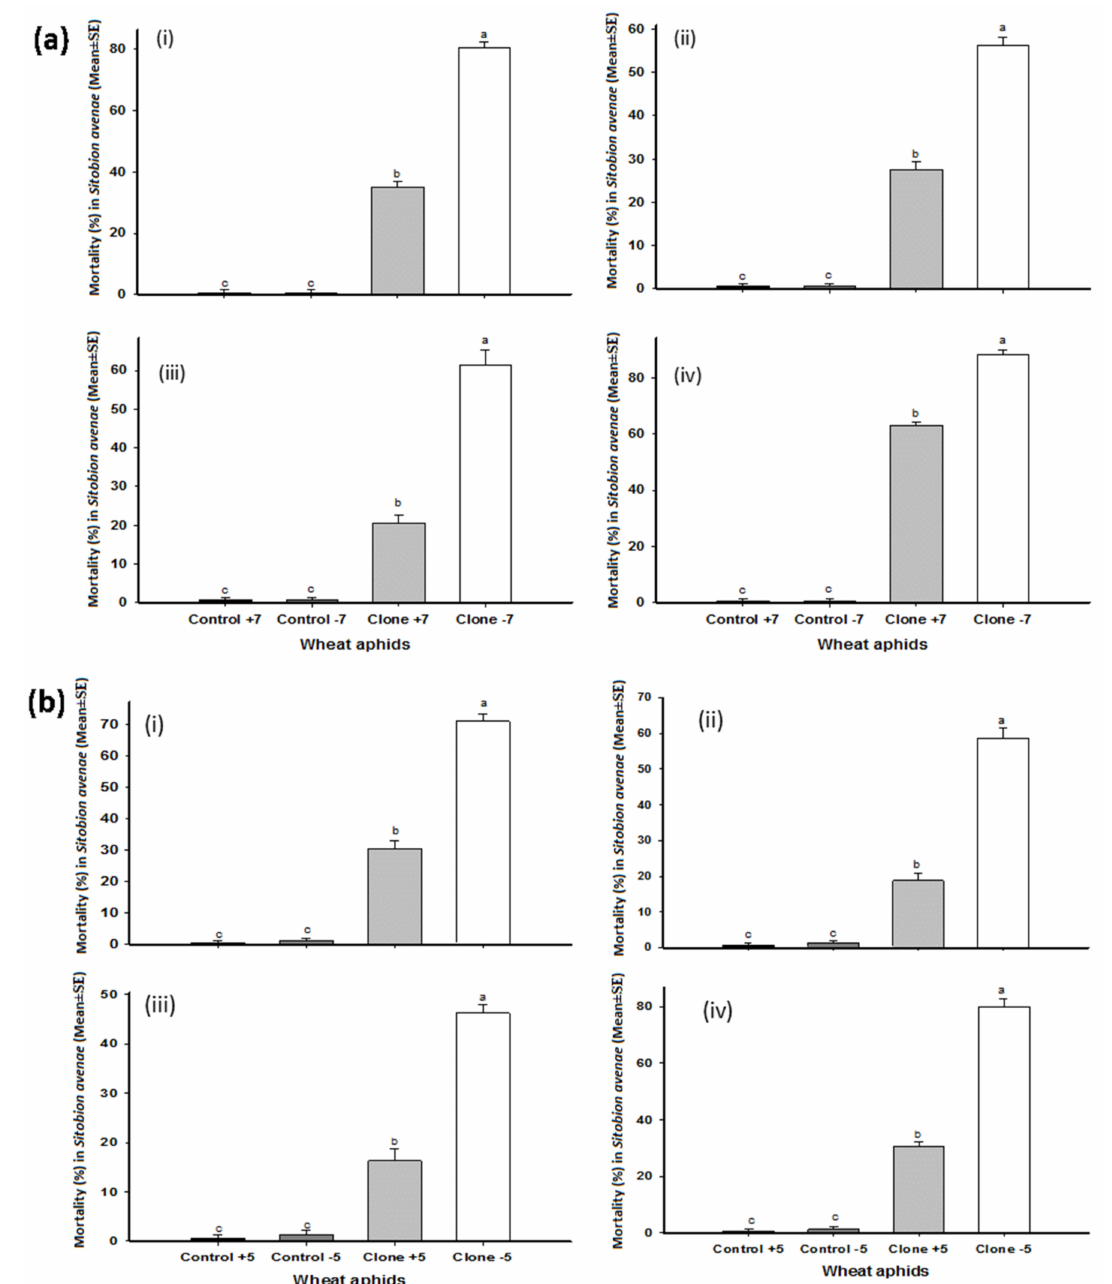
Figure 1. Total mortality in wheat aphid ( Sitobion avenae ) clones +7, − 7 ( a ) and +5, − 5 ( b ) after five days of application of Beauveria bassiana strains Bb1022 (i) and EABb04/01-Tip (ii) and Metarhizium brunneum strains ART 2825 (iii) and BIPESCO 5 (iv). The letters (a, b, c) are indicating the significance difference among the